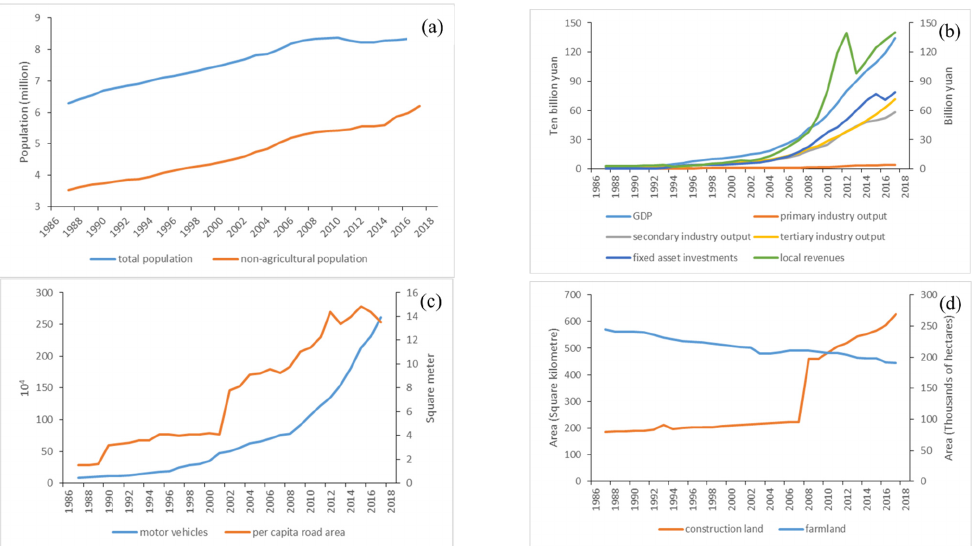
Figure 4. Temporal variations of ( a ) population, ( b ) economical conditions, ( c ) social development and ( d ) areas of farmland and construction land from 1987 to 2016 in Wuhan.